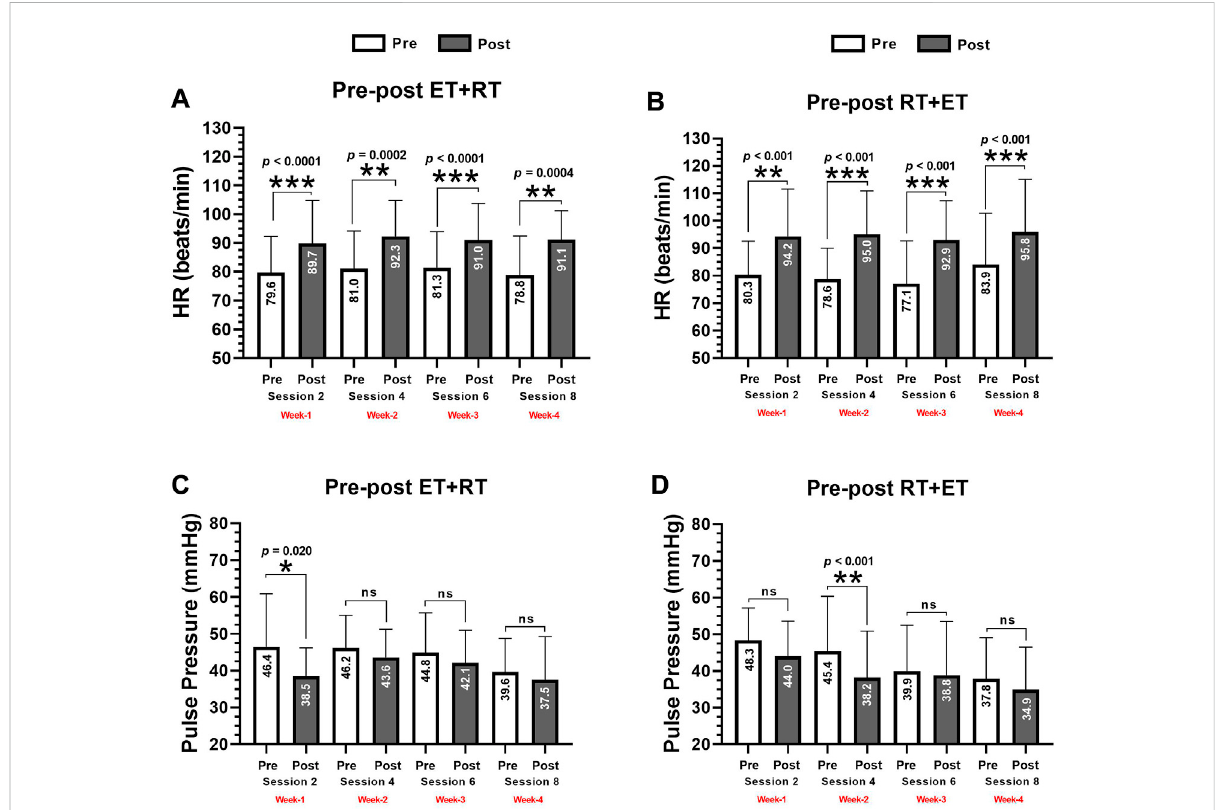
FIGURE 4 Acute absolute prepost changes in heart rate at rest (A, B) and in pulse pressure (C, D) after 4weeks(eightexercise sessions) of two different orders ofconcurrent training in morbid obesity patients. Groupsare described as (ET + RT) endurancetraining plusresistance training group and (RT+ ET) resistancetrainingplusendurancetraininggroup.Outcomesaredescribedas(HR)Heartrateatrest.(*)denotessigni fi canttimeprepostdifferences in each week at p < 0.05. (**) denotes signi fi cant time prepost differences in each week at p < 0.001. (***) denotes signi fi cant time prepost differences in each week at p < 0.0001. (ns) denotes no signi fi cant differences p >